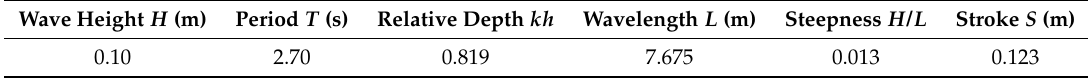
Table 3. Wave parameters in the numerical simulation Cases I-1 and I-2.